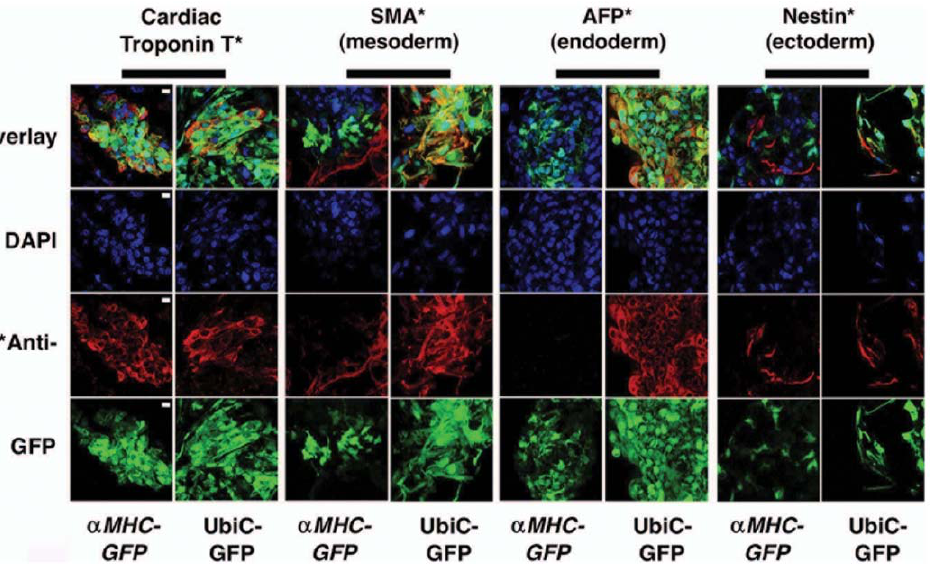
Figure 1. The a MHC-GFP reporter line is cardiac-specific. hESCs from either the a MHC-GFP or UbiC-GFP reporter lines were differentiated for 14 days by hEB formation, and analyzed by direct and indirect immunofluorescence for expression of GFP and cTnT, SMA, AFP or nestin, respectively. Cells were counterstained with DAPI to identify nuclei. Typical micrographs are shown. Co-localization of GFP solely with cardiac troponin T, but not SMA, AFP or nestin, was seen in differentiated a MHC-GFP hESCs. In contrast, co-localization of GFP with all four markers was seen in differentiated UbiC-GFP hESCs. Bar, 100 m m.